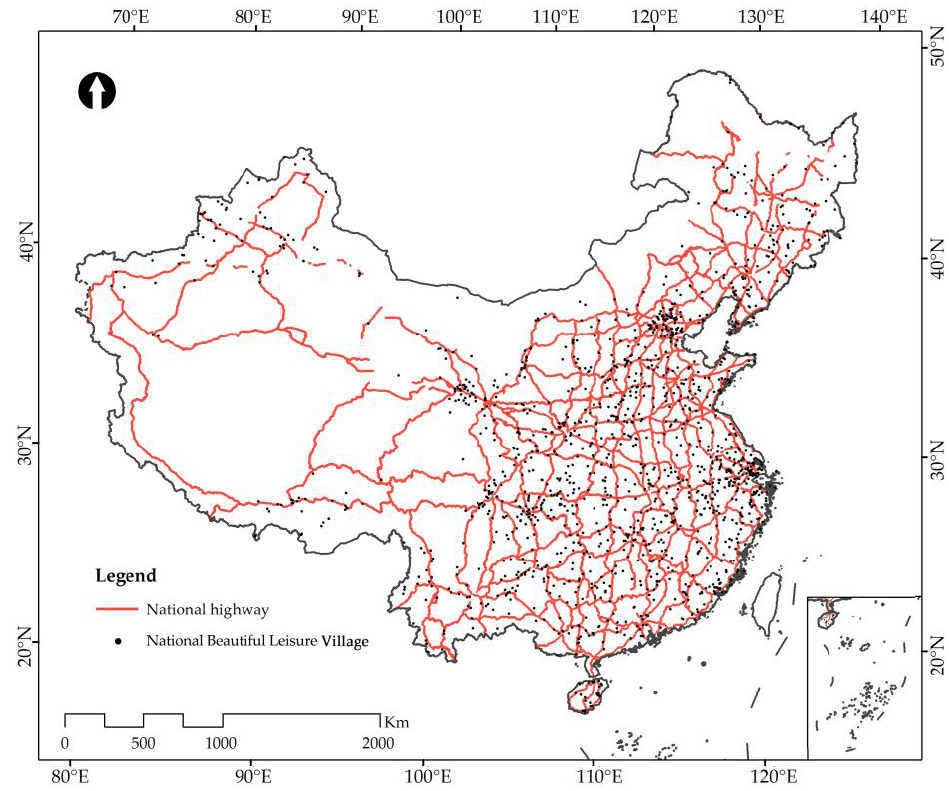
Figure 9. Distribution map overlapping beautiful leisure villages and traffic in China.